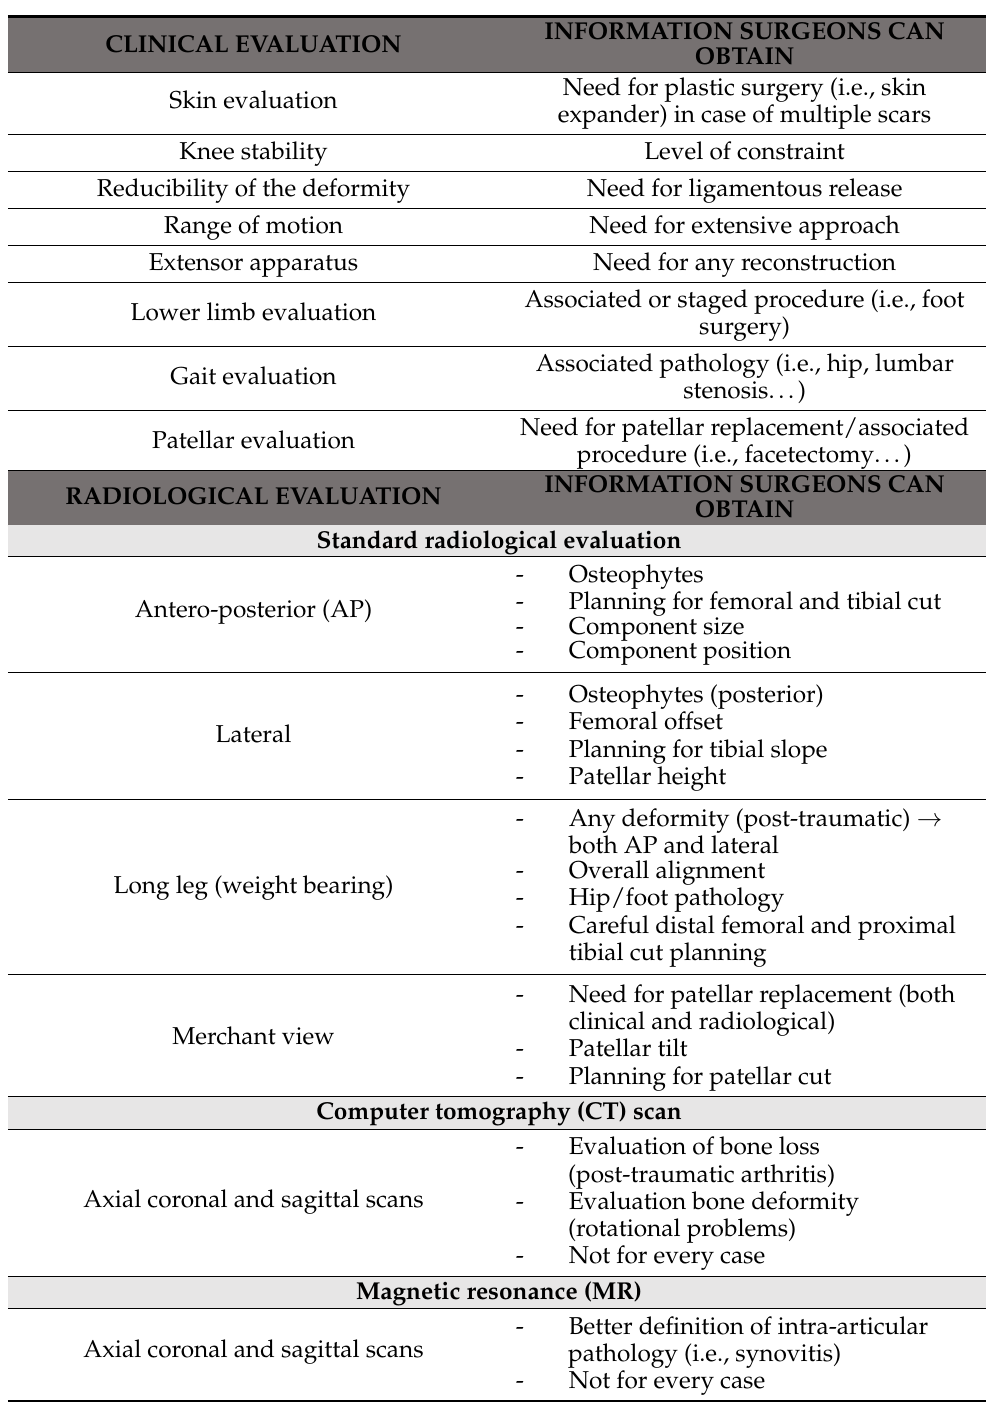
Table 1. Summary of information available to the surgeons with standard pre-operative planning for primary